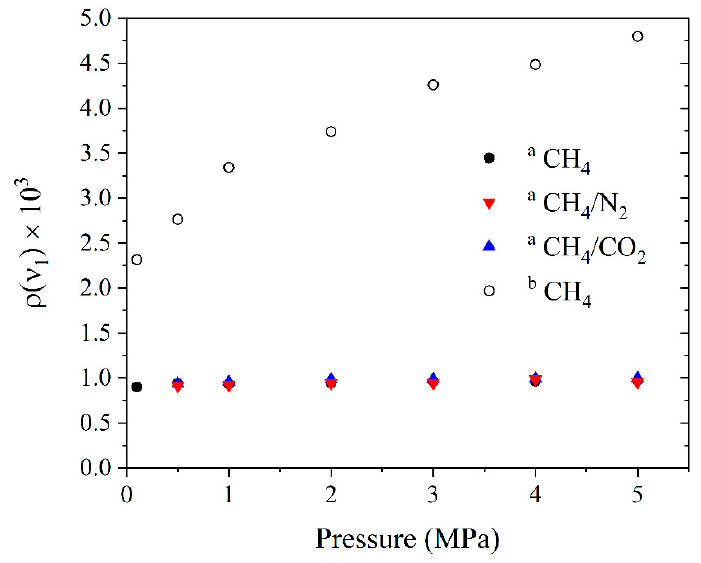
Figure 5. Depolarization ratio of the ν 1 band of CH 4 as a function of pressure at different molecular environments, where label a denotes the data obtained after the subtraction procedure of the simulated spectrum of the ν 3 and ν 2 + ν 4 bands, and label b is the data obtained without the subtraction.